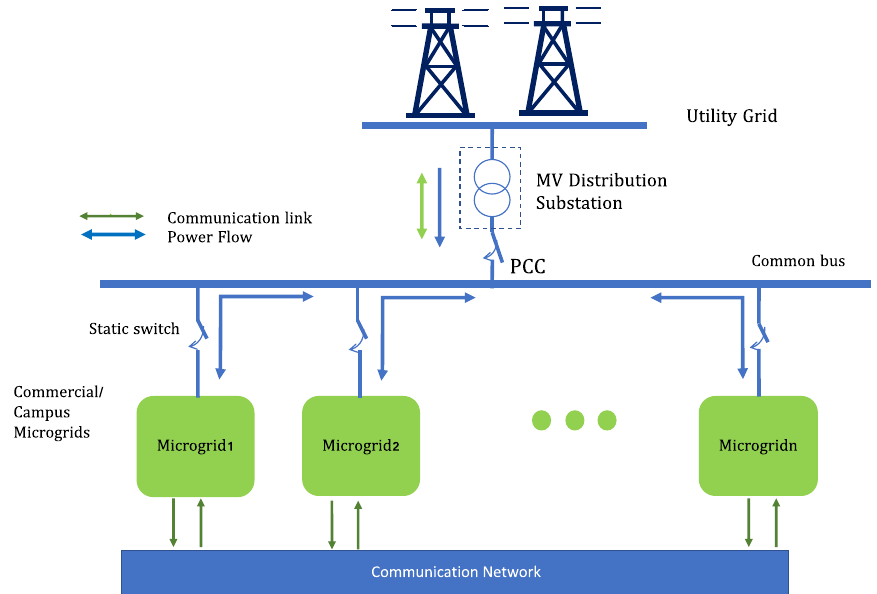
Figure 1. Schematic of multiple MGs that are connected to a common bus by static switches and can exchange information via a communication network.